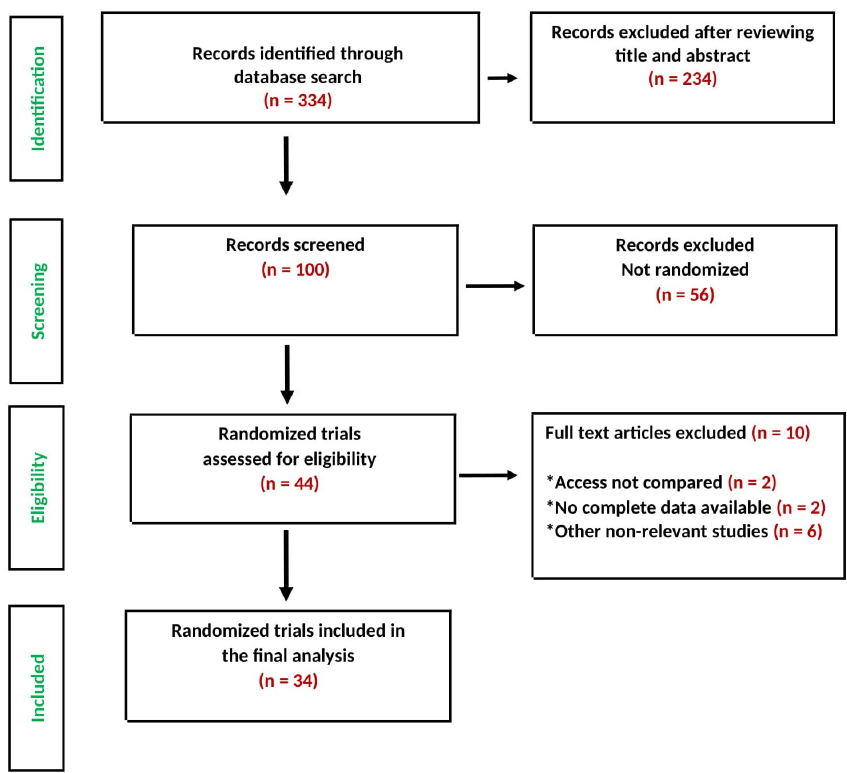
Figure 1. PRISMA study selection flow chart.